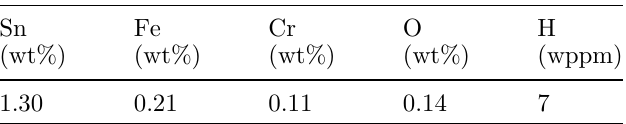
Table 1. Ingot chemical composition of the tested SRA